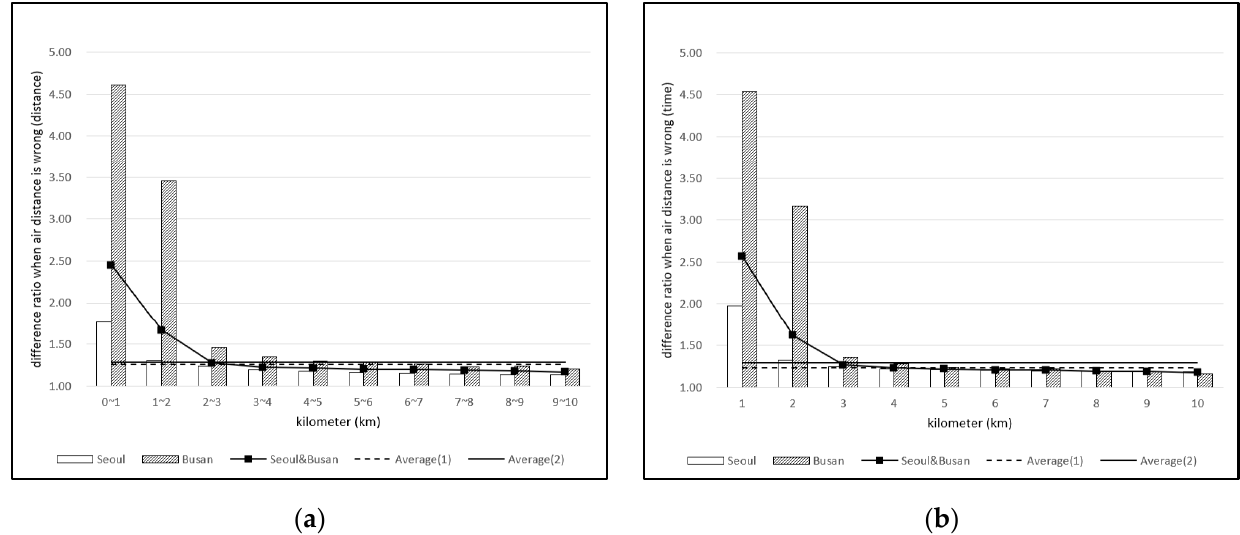
Figure 9. The magnitude of closeness deceived by air distance: ( a ) Road distance; ( b ) road time.